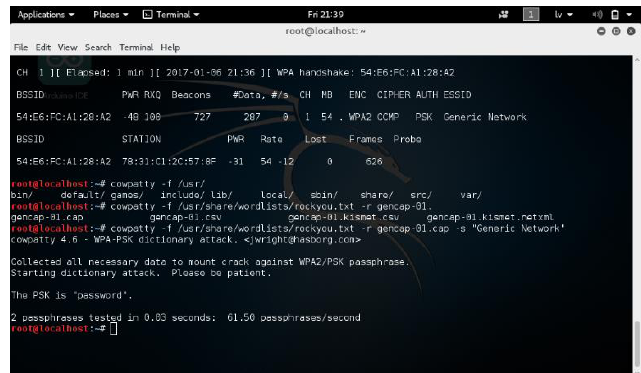
Fig. 6. Screenshot of Kali Linux terminal emulator with the acquired WPA2 key using